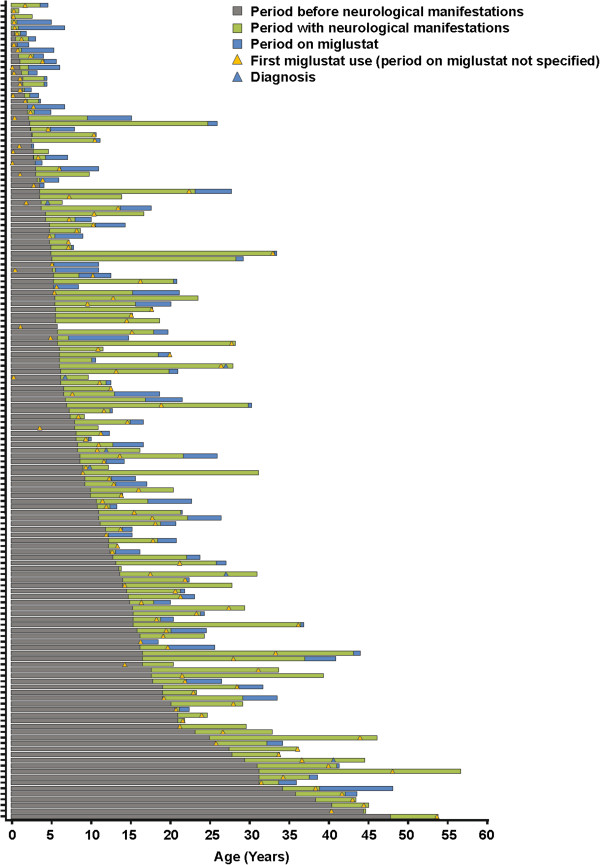
Overview of patient and disease characteristics.